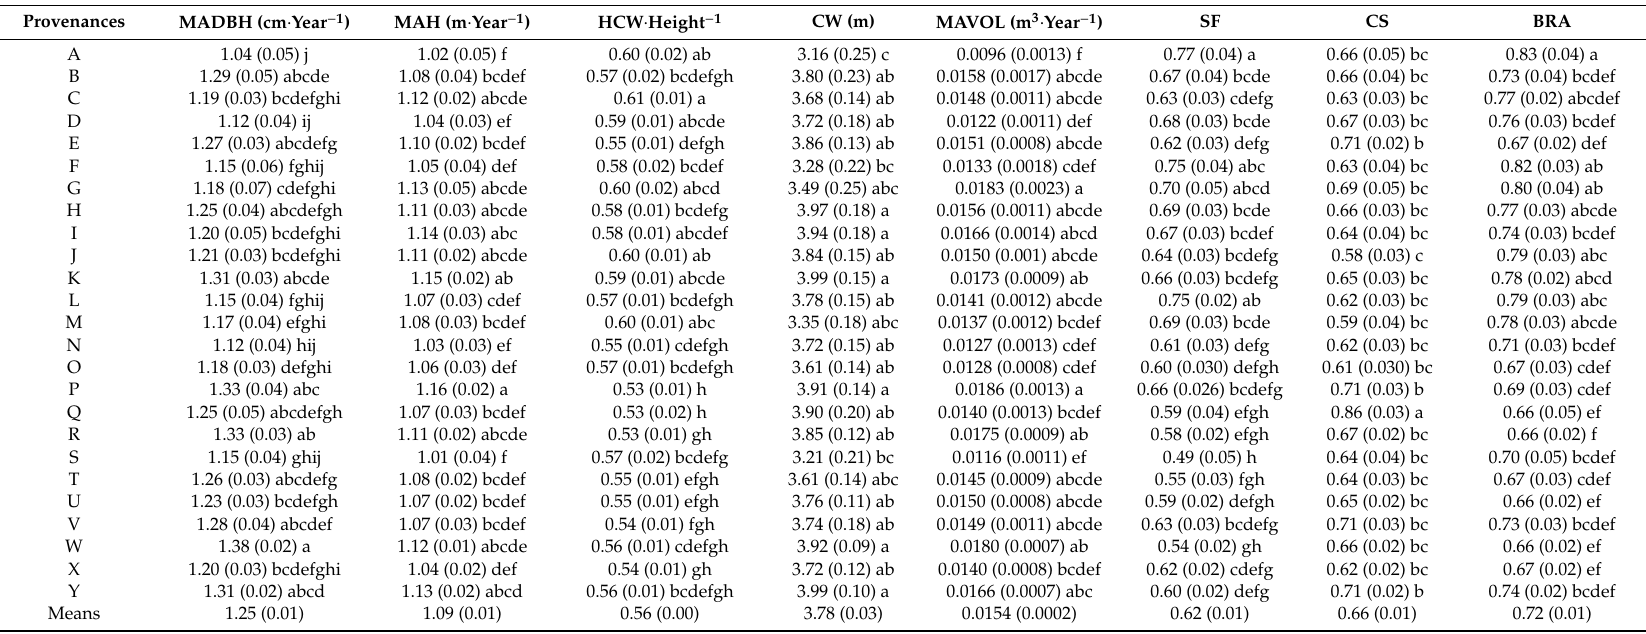
Table 3. Growth and quality performance for 25 provenances of Betula alnoids